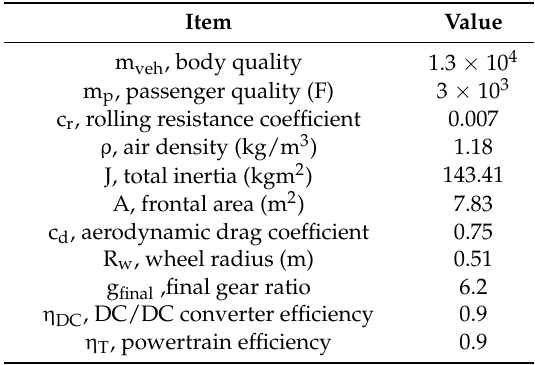
Table 3. Basic parameters of the